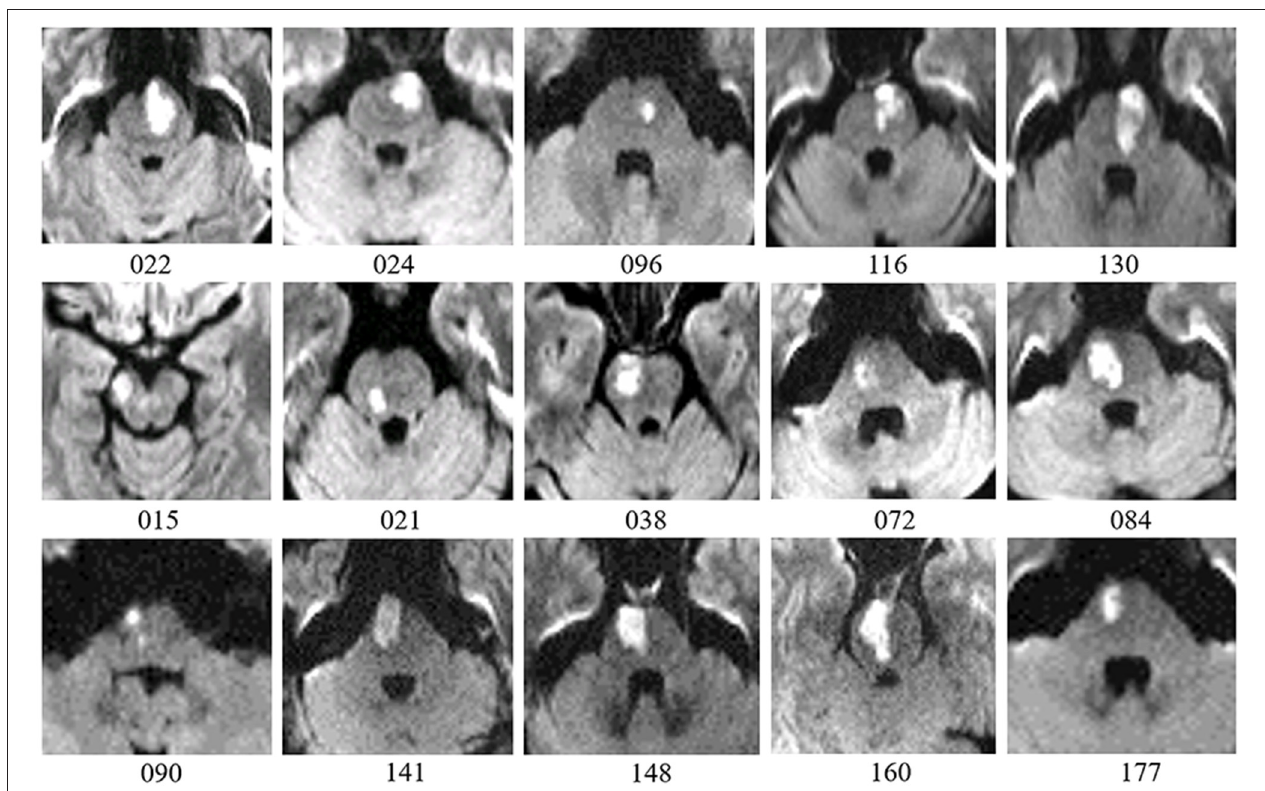
FIGURE 1 | Lesion details of patients with pontine infarction are depicted in axial DWI maps. Number below each image is the participant ID presented in Table 1 . Five patients with lesions on the left side are placed on the first row, while 10 patients with lesions on the right side are shown on the following 2 rows. For all images, right is displayed on the left (radiological